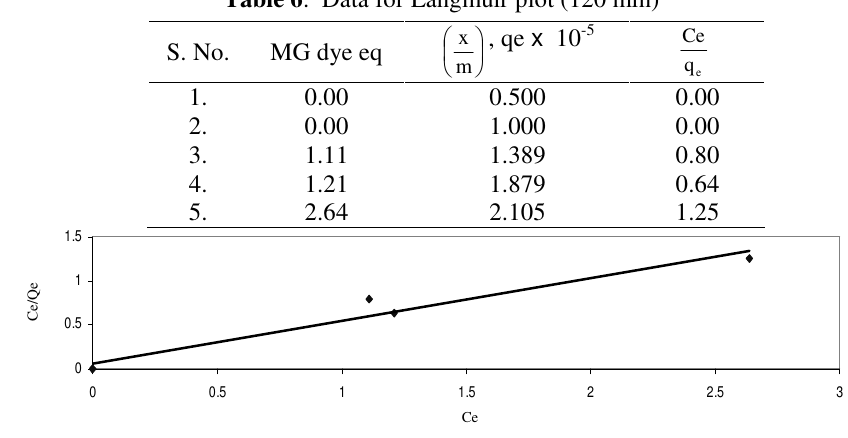
Figure 6 . Data for Langmuir plot (120 min)